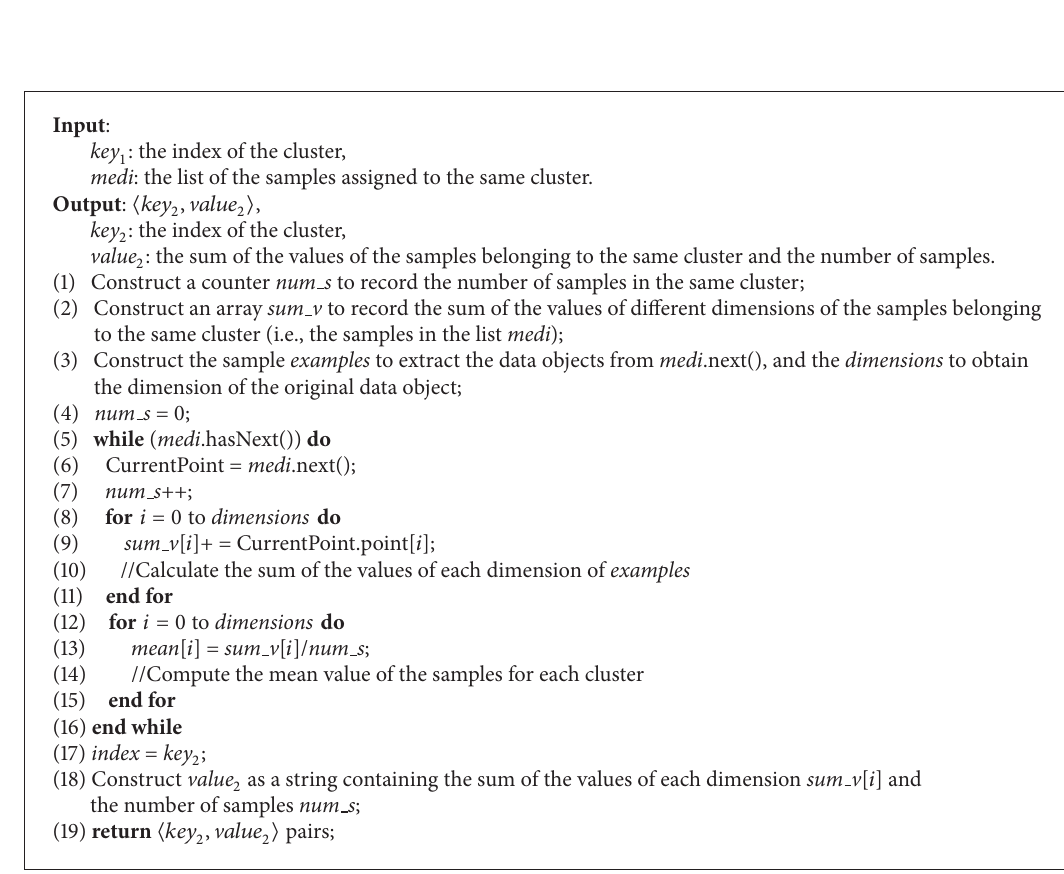
Algorithm 1: Map( key , value ).